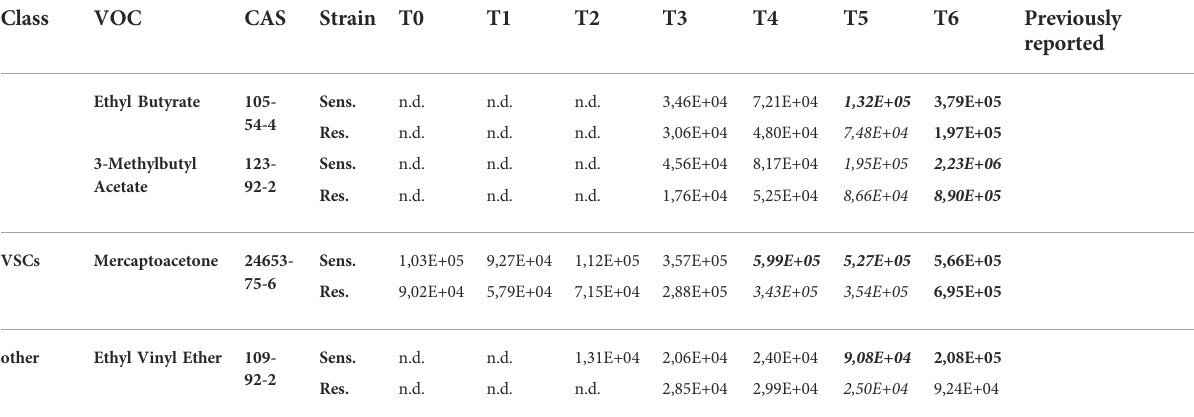
Tablelegend: Sens .,asensitivestrainofKPN; Res .,aresistantstrainofKPN; boldvalueofpeakarea ,indicatesthestatisticallysigni fi cantdifference(Kruskal-Wallistest)betweenthetimepointof interest and T0. Underlined italic value of peak area , indicates the statistically signi fi cant difference (U-Mann-Whitney test) between resistant and sensitive strain at the same timepoint.